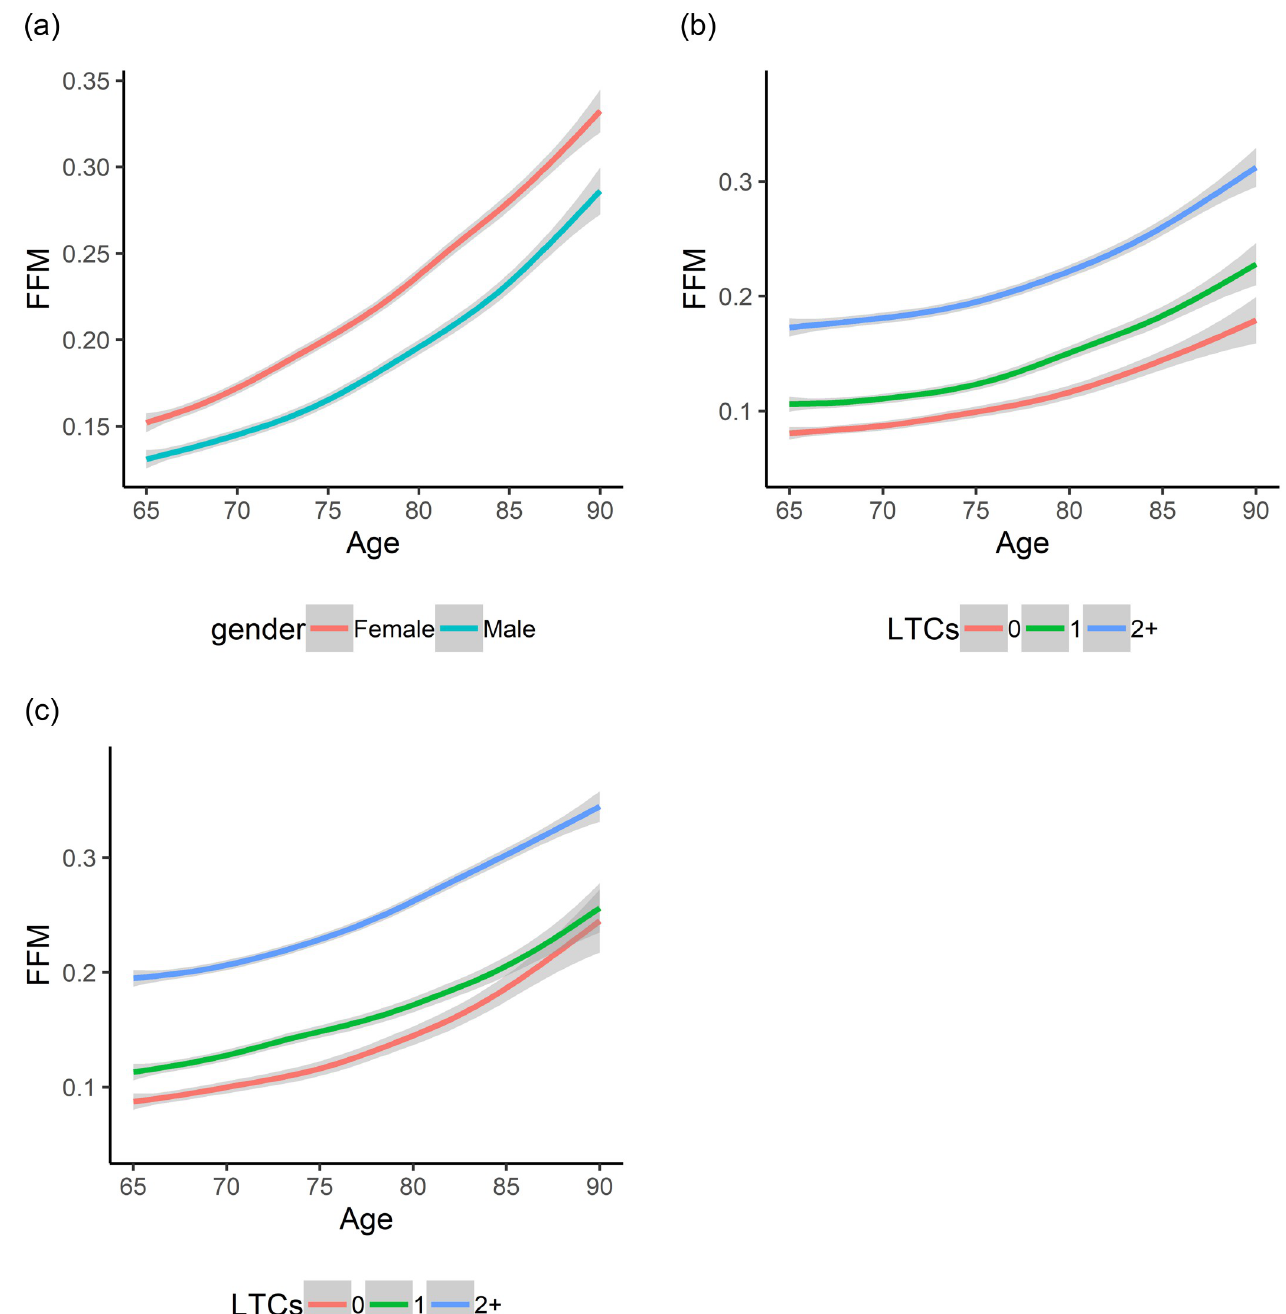
Fig 2. FMM against age using regression splines. a) FMM vs age grouped by gender. b) FMM vs age grouped by gender LTCs for males. c) FMM vs age grouped by gender LTCs for females. multimorbid participants on average have a higher frailty as they aged in both